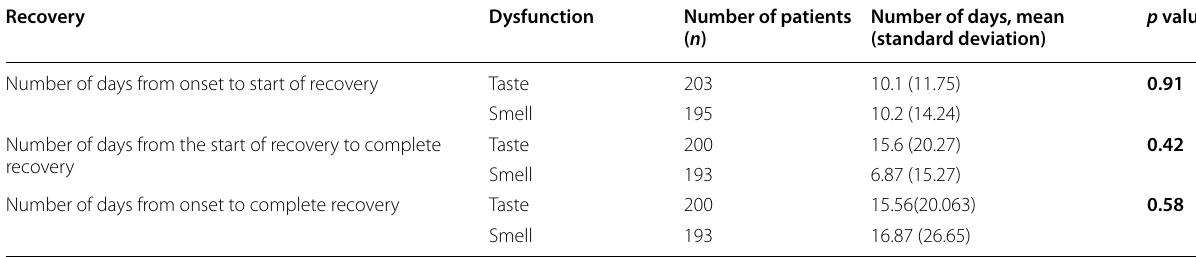
Table 5 Time taken from onset to beginning of recovery and to complete recovery Recovery